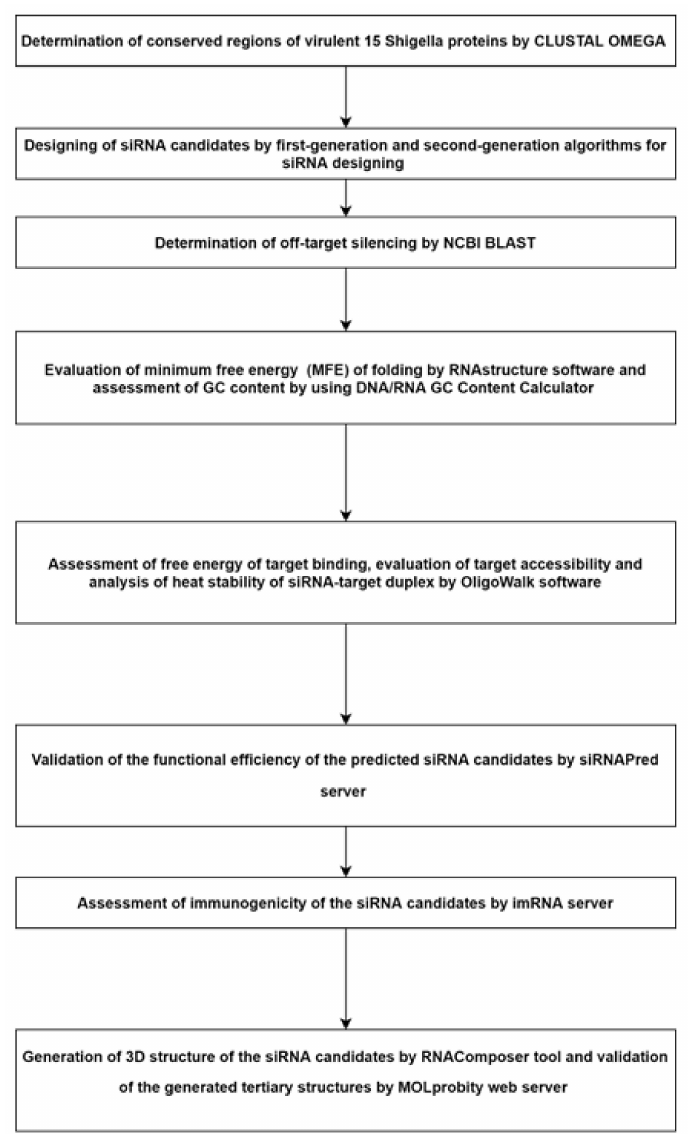
Figure 1. Overview of the workflow of the methodology followed in the